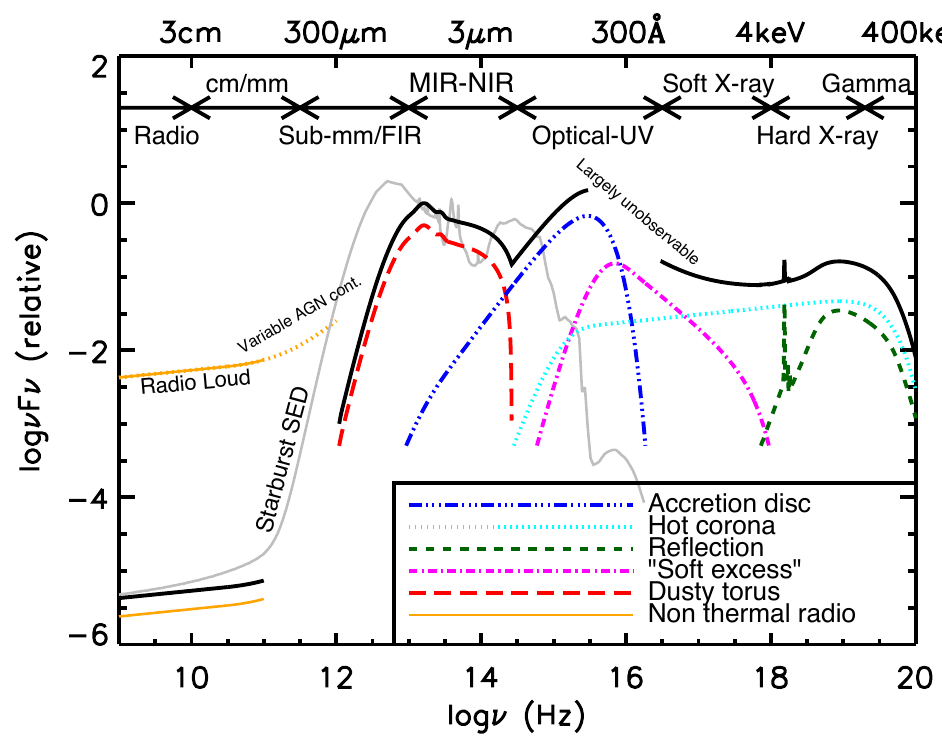
Figure 1. Schematic representation of the AGN SED (black curve), separated into the main physical components, as indicated by the colored curves. For comparison, the SED of a star-forming galaxy (light gray curve) is also shown. Taken from Harrison [52], Hickox and Alexander